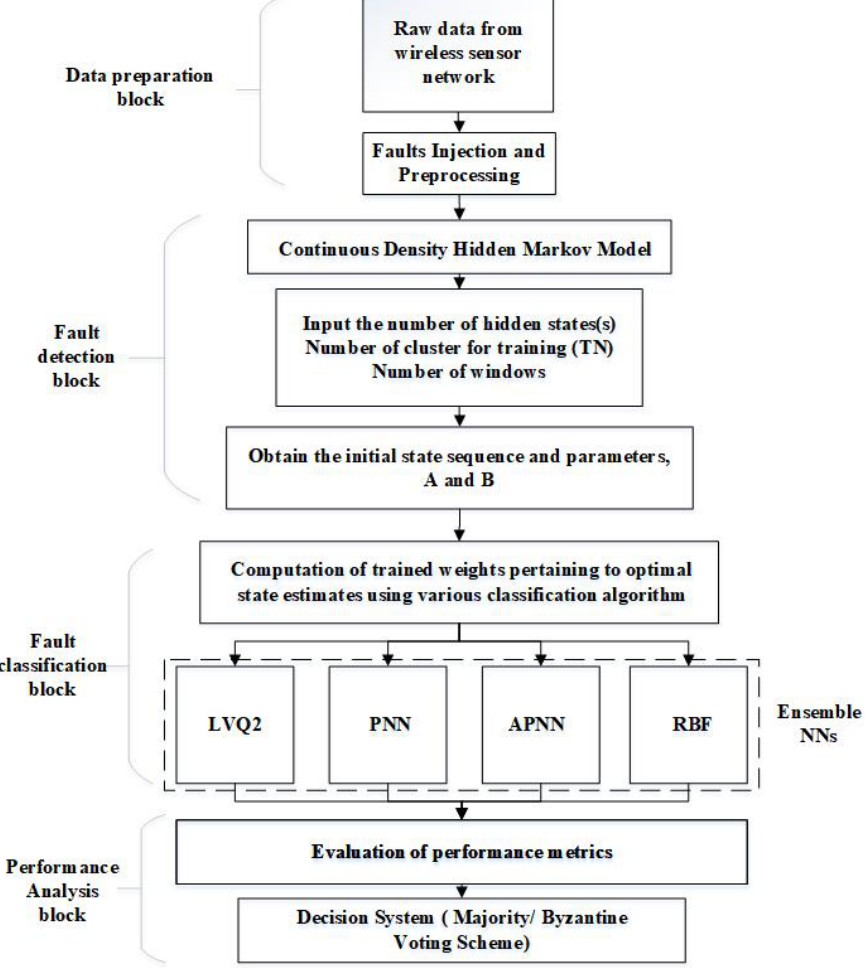
Figure 4. Proposed framework for the detection and classification of sensor